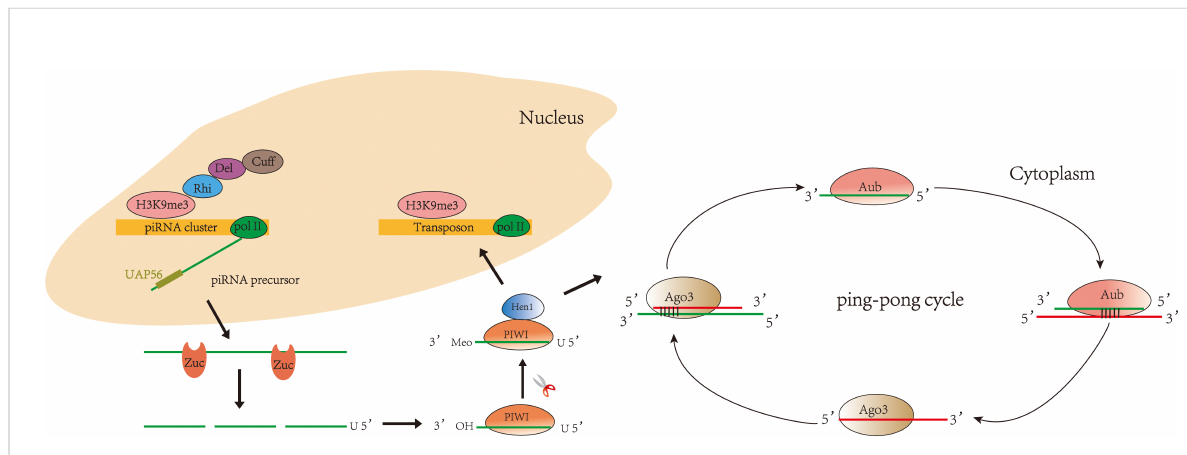
FIGURE 1 Biogenesis of piRNA: primary pathway and secondary pathway. In the primary pathway, piRNA forms a complex with PIWI proteins to mediate transposon silencing. In the secondary pathway, piRNA binds to Aub to produce secondary piRNA, while secondary piRNA binds to Ago3 to produce primary piRNA, and so the cycle